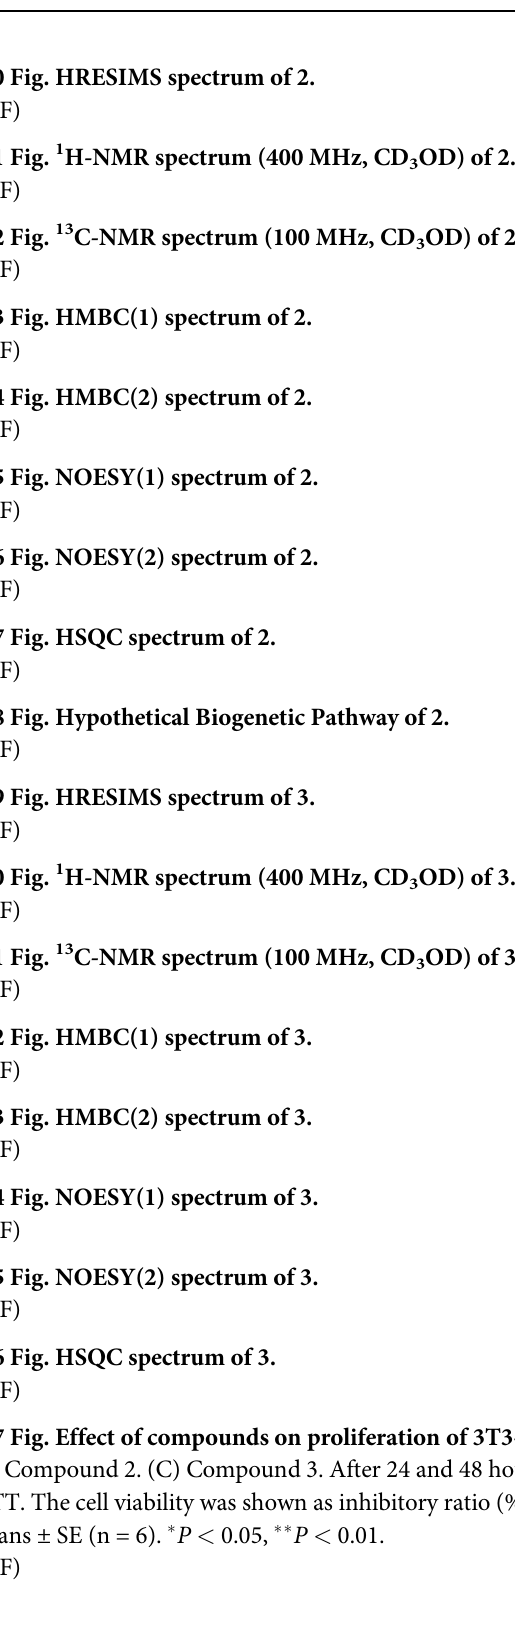
OD) of 2. 3 OD) of 2. 3 OD) of 3. 3 OD) of 3. 3